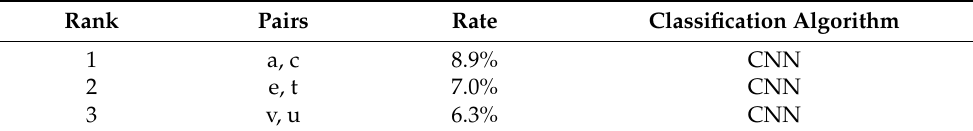
Table 3. The three pairs of characters with the highest misclassification rate.